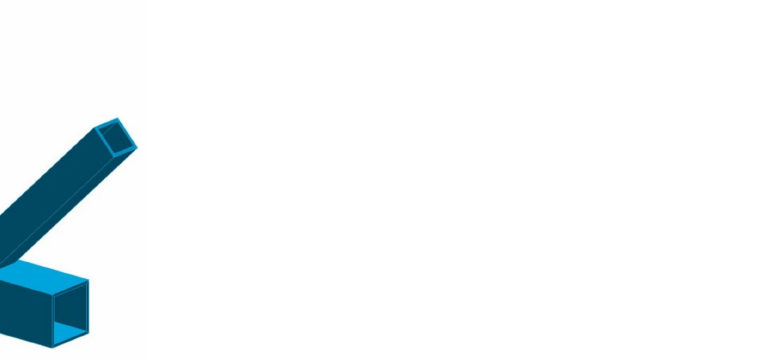
Figure 11. Axonometric view of the analyzed truss joints from the Autodesk ROBOT 2021.